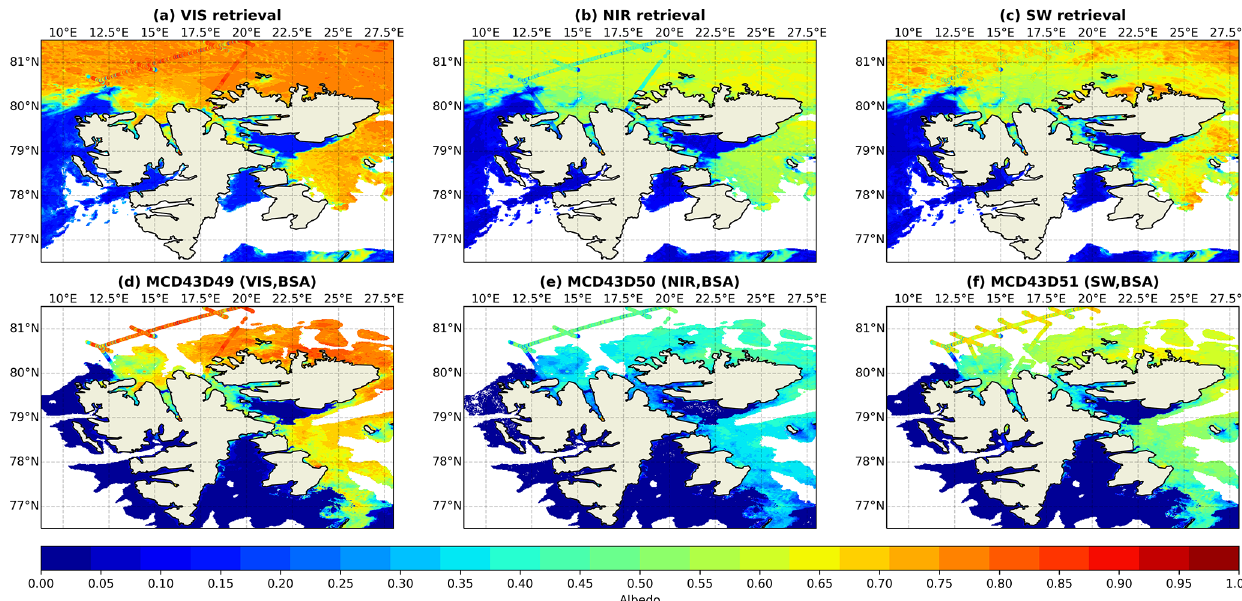
Figure 12. Albedo retrieval maps on 25 June 2017 in the shallow-ocean region near Svalbard. The albedometer measurements from the ACLOUD campaign are superimposed over the retrieval maps in each panel. Note that both low- and high-level flight measurements are included. (a–c) The visible, near-infrared, and shortwave (VIS, NIR, SW) albedo values derived using the RTM–SciML-albedo product and MODIS radiance data. (d–f) The three broadband black-sky albedo values (BSAs) derived by MCD43D49-51. The empty regions in panels (a) to (c) correspond to cloud coverage throughout the day on 25 June 2017, whereas the empty regions in panels (d) to (f) correspond to ocean areas where MCD43 does not provide retrievals.